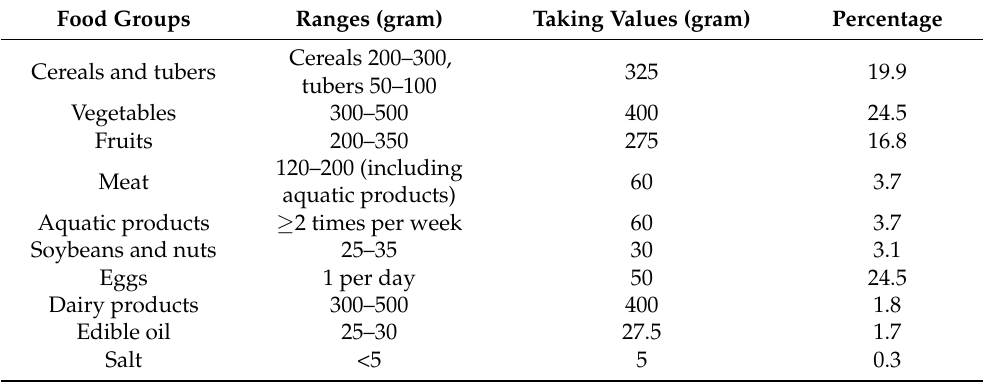
Table A4. Recommended food intake range in the CDG, the median value within this range, and the proportion of this food group among all food